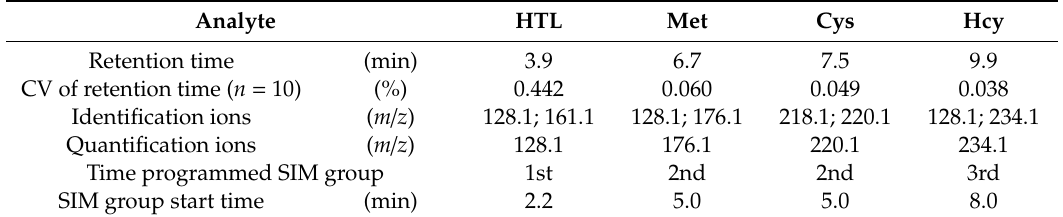
Table 1. Analytical characteristics of HTL / Met / Cys / Hcy-TMS derivatives using SIM MS mode.